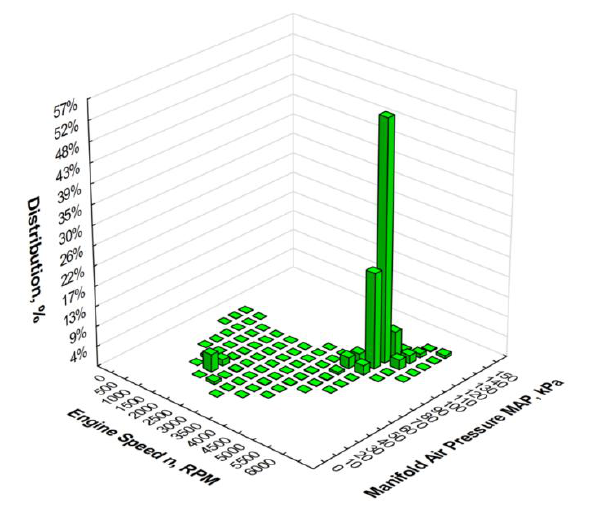
Fig. 5. Distribution of engine operating points during the sport competition To further analyze the engine speed distribution, the analysis was performed with reduced intervals to 100 rpm